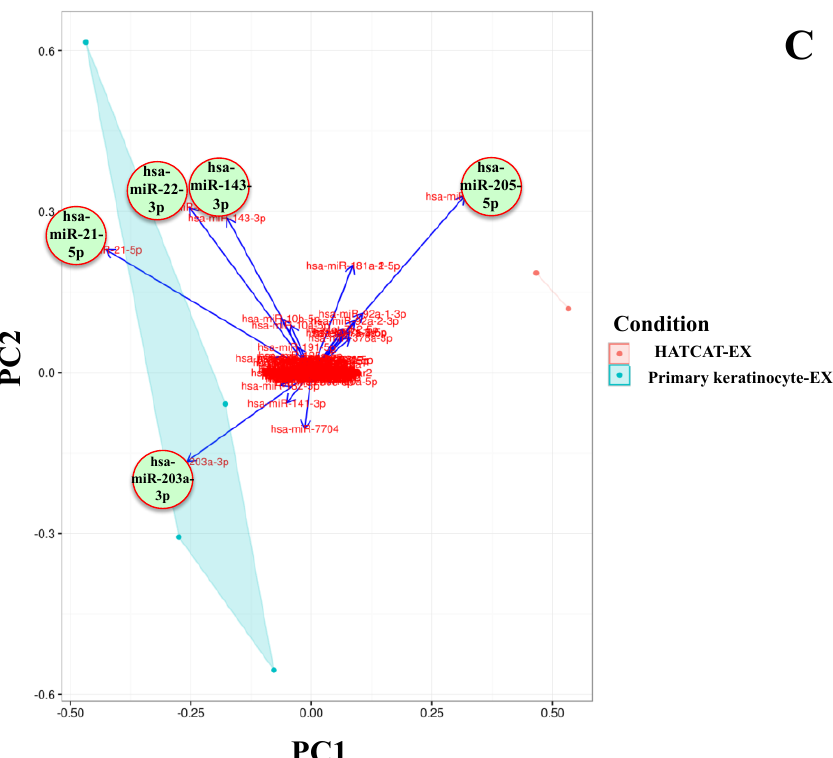
Figure 1. miRNA-205 is more associated with HaCaT cells and miRNA-21, miRNA-203, miRNA-22 and miRNA-143 are more associated with PKCs. Identified miRNAs from: ( A ) APs; ( B ) MVs; and ( C ) EXs. Biological replicates for HaCaT (n = 2) and PKCs (n = 4).